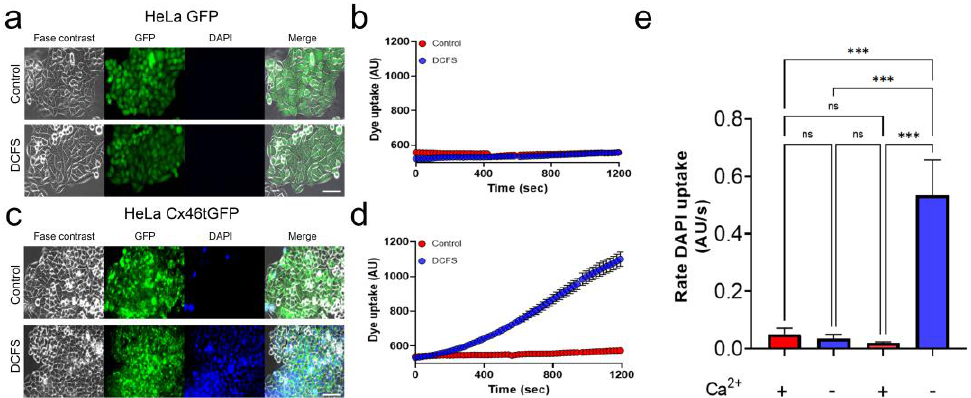
Figure 1. Only HeLa cells transfected with Cx46tGFP show DAPI uptake in DCFS. HeLa cells were transfected with GFP or Cx46tGFP and DAPI uptake time-lapse recordings were performed. ( a ) Pictures of a culture of HeLa cells expressing GFP (HeLa-GFP) revealed that almost all HeLa cells express this protein (merge panels). After 20 min of exposure to 10 μ M DAPI, HeLa-GFP cells do not show DAPI uptake, either under control conditions or in DCFS (DAPI panel). ( b ) Representative quantification of DAPI uptake in time-lapse experiments showing that the rate of DAPI uptake in HeLa-GFP cells under control (red dots) and DCFS (blue dots) conditions is very similar. ( c ) HeLa cells transfected with Cx46tGFP (HeLa Cx46tGFP) do not show significant DAPI uptake in control conditions (DAPI panels). However, DAPI uptake was greatly increased when cells were placed in DCFS. ( d ) Representative quantification of DAPI uptake in time-lapse experiments showing a significant increase in DAPI uptake in HeLa Cx46tGFP in DCFS (blue dots) in comparison to the control condition (red dots). Each dot corresponds to the average intensity of DAPI fluorescence in the nucleus of 16 different cells. ( e ) Graph showing the average of n = 3 independent experiments for each condition (control and DCFS). p > 0.05 = n.s, and p < 0.001= ***.